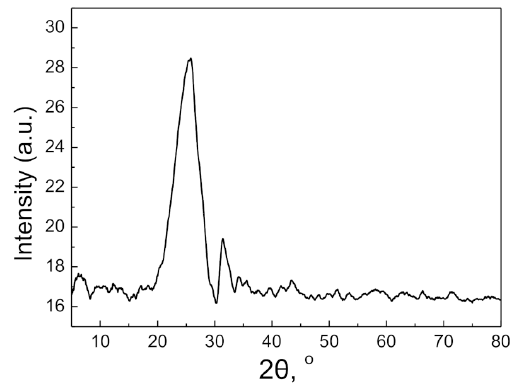
Figure 6. XRD pattern of the Na–BC